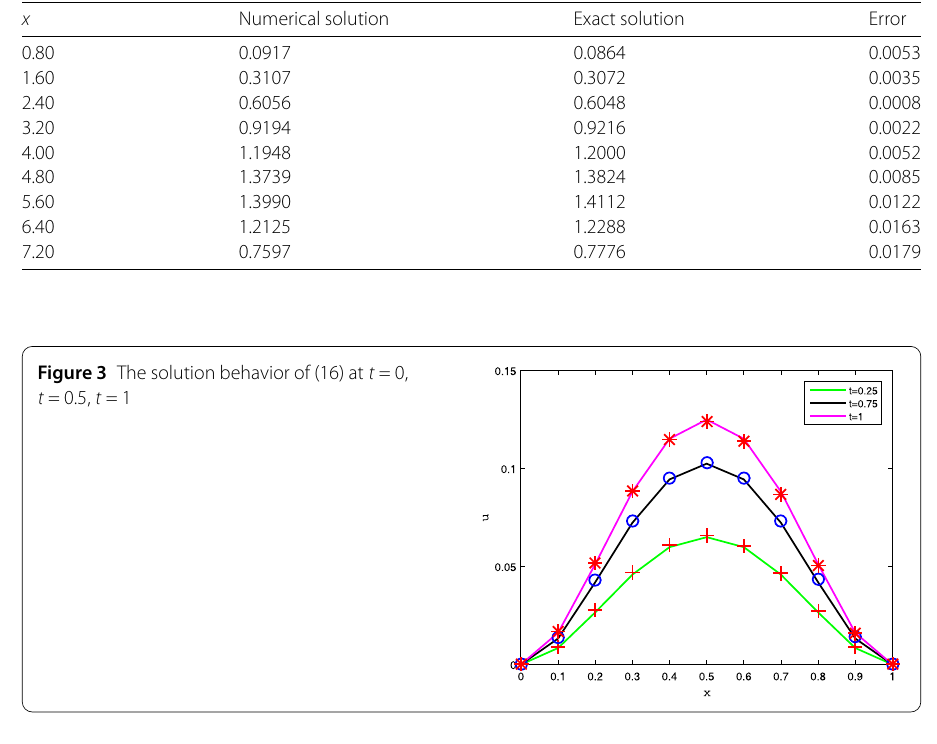
Table 2 Numerical solution, exact solution, and absolute error at T = 1.0 of (16)